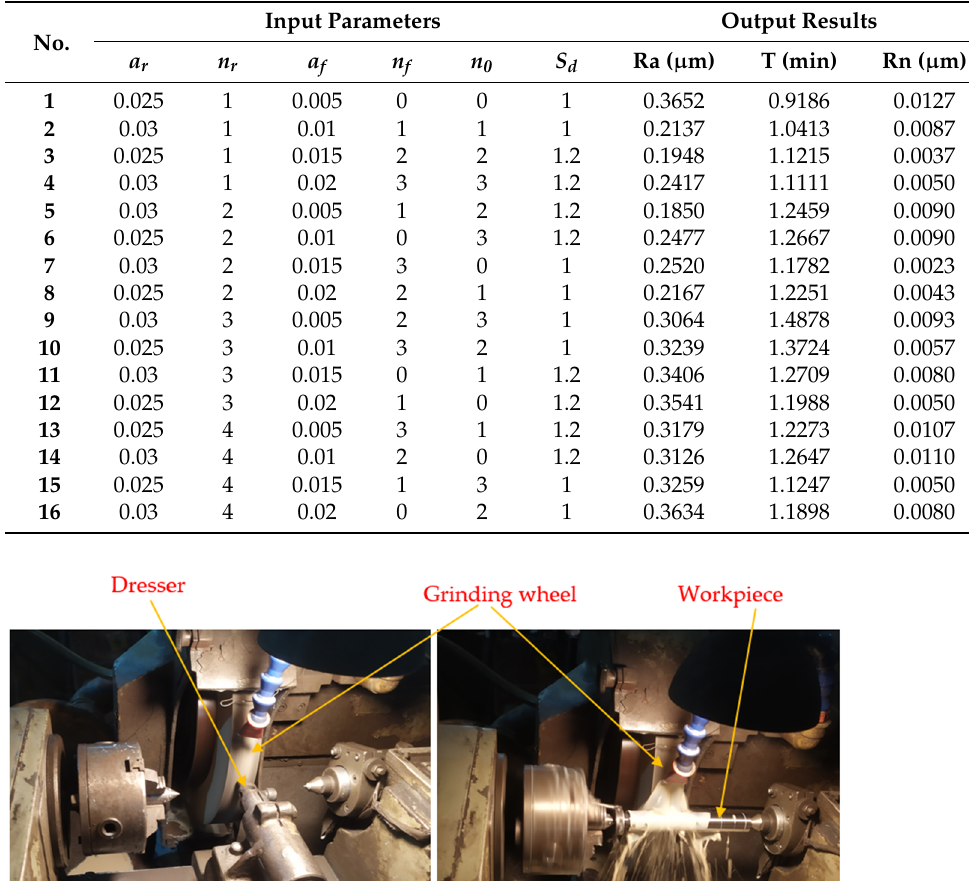
Table 3. Experimental matrix and output results.